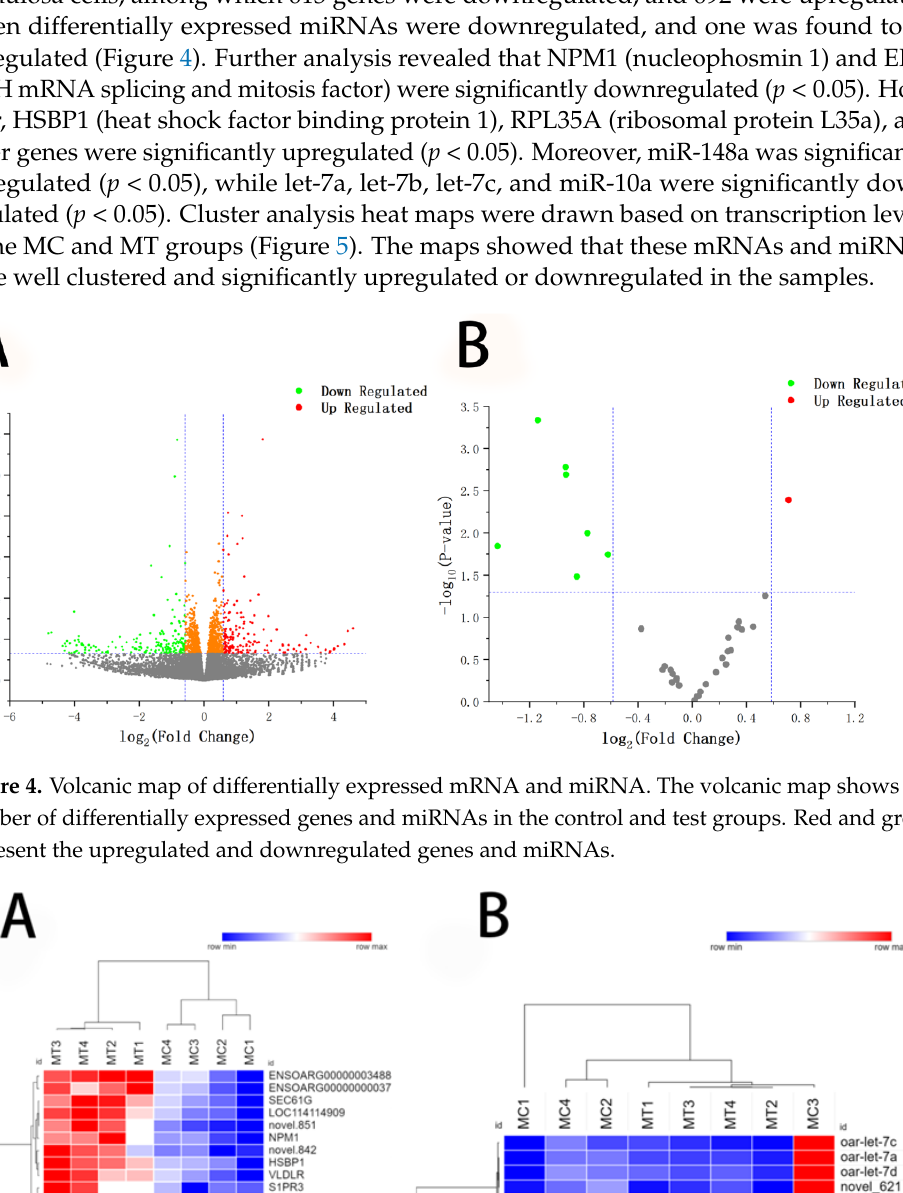
Figure 3. Small RNA classification notes . ( A ) Classification notes for test groups. ( B ) Classification notes for control groups.